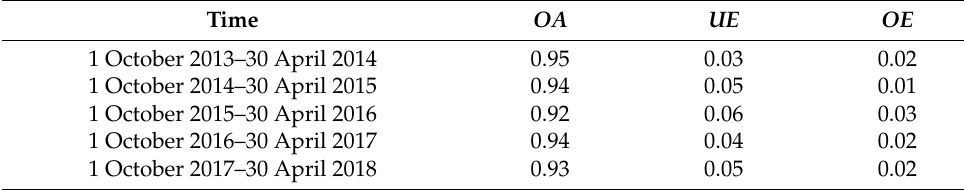
Table 3. Accuracy evaluation results for ground observation stations.